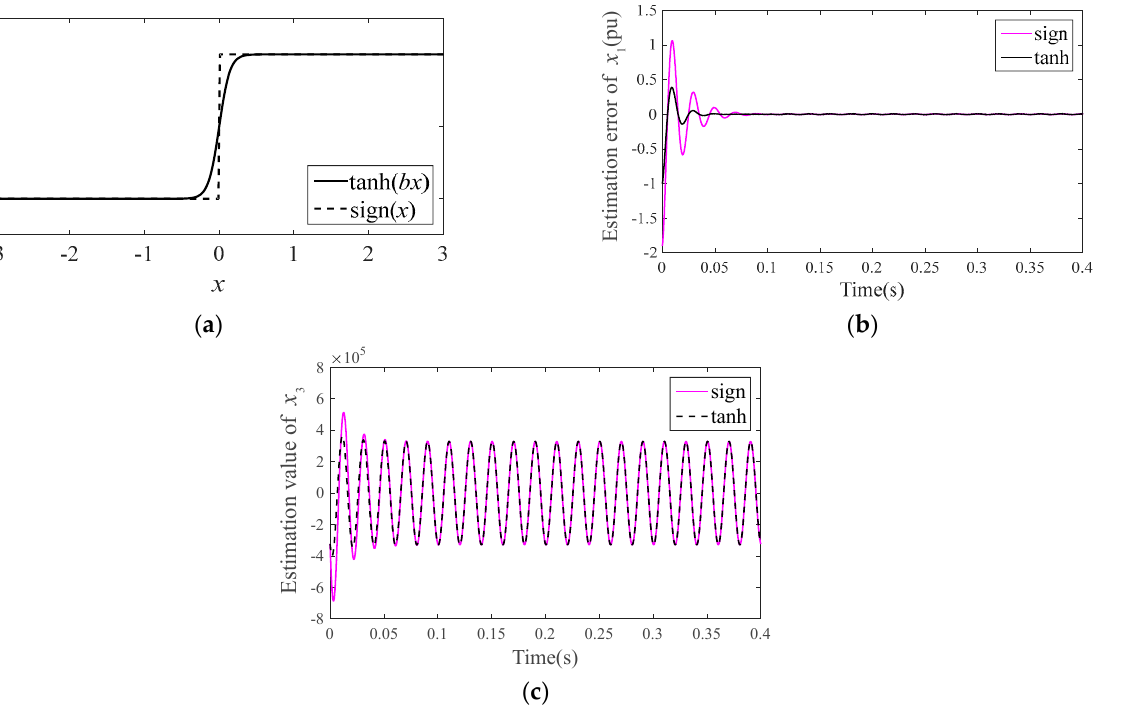
Figure 3. Effect comparison of ESO with different nonlinear functions: ( a ) comparison between hyperbolic tangent function and sign function; ( b ) the estimated error value on system state x 1 of ESO with different nonlinear functions; and ( c ) the estimated value of extended state x 3